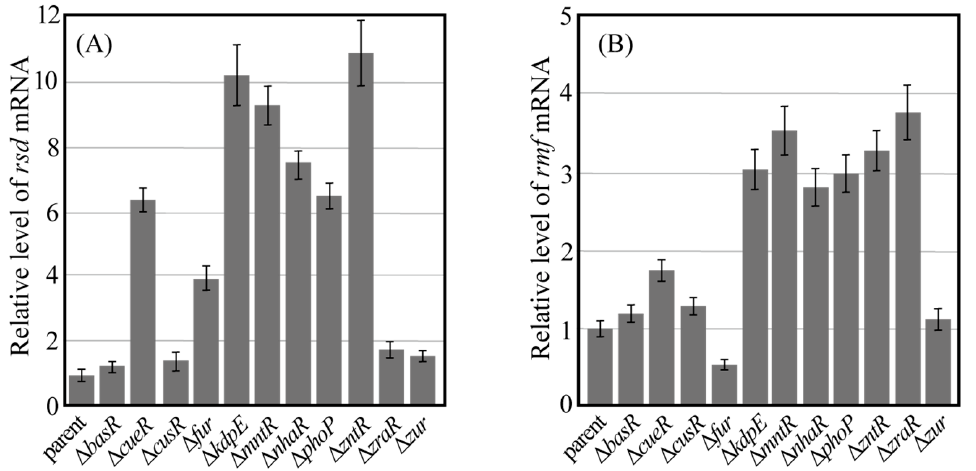
Figure 4. Amount of mRNA transcribed from rsd and rmf genes. The parental strain (parent) and each mutant strain lacking the transcription factor gene were harvested 24 h after inoculation. The amount of mRNA transcribed from the rsd ( A ) and rmf ( B ) genes in the cells was measured using qPCR. Values for each mutant were normalized against the value from their corresponding parent. Notably, each measurement was taken at least three times.